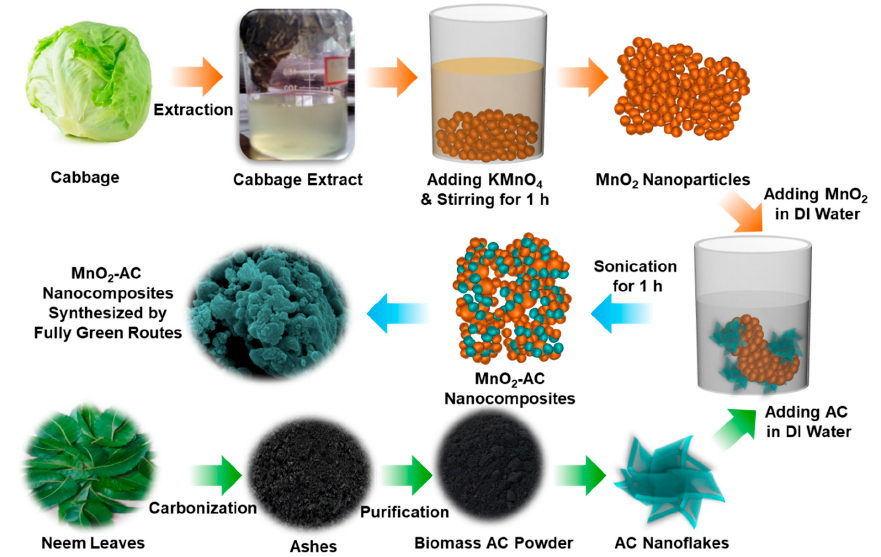
Figure 1. Schematic illustration for the fabrication of MnO 2 nanoparticles, AC nanoflakes, and MnO 2 ‐ AC